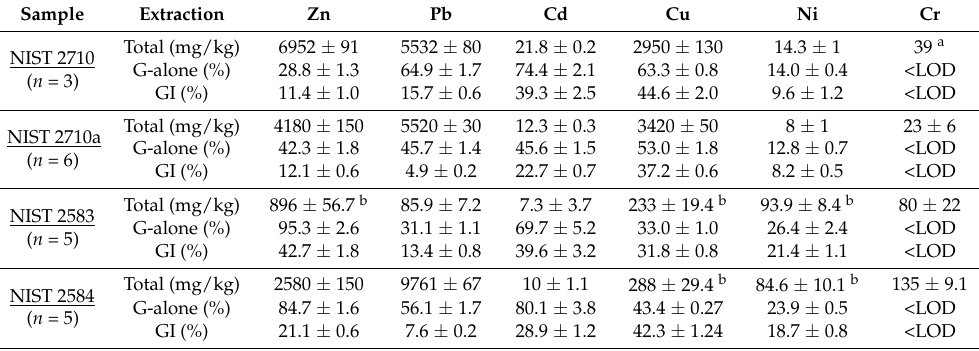
Table 2. Percent bioaccessibility of metals (mean ± standard deviation) in certified reference materials for the gastric (G-alone) and gastrointestinal (GI) PBET extraction phases. Total concentrations are certified values reported in the Certificates of Analysis unless indicated